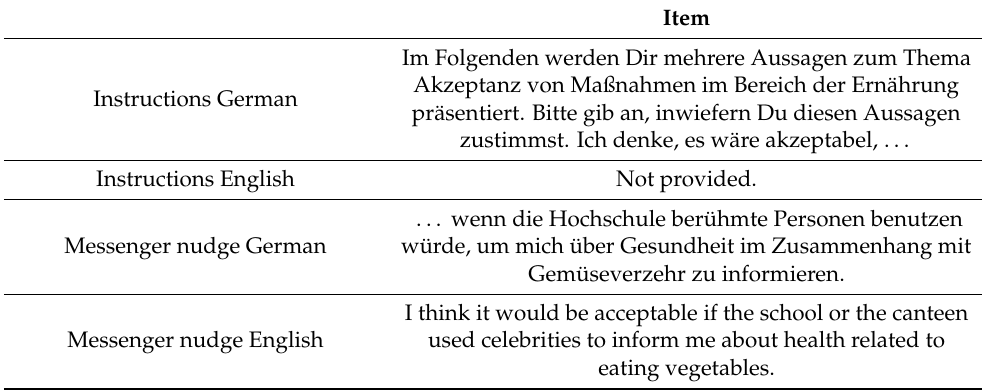
Table A1. German and English items measuring nudge